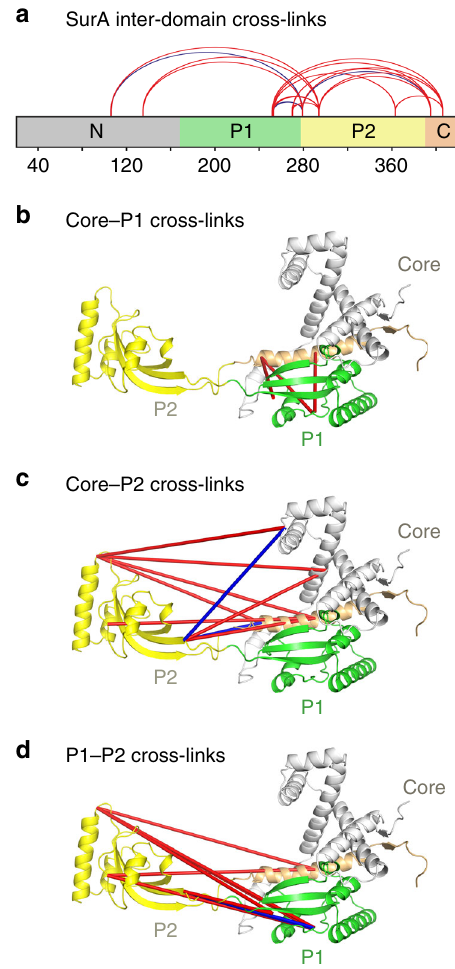
Fig. 2 XL-MS suggests the P2 domain is closer to the core/P1 than implied by the crystal structure. a Locations of the 19 identi fi ed SurA inter- domain cross-links (red and blue lines). b – d Crystal structure of SurA showing the identi fi ed inter-domain cross-links between b core-P1 (3 in total), c core-P2 (9 in total), and d P1-P2 (7 in total). Only four of the inter- domain cross-links identi fi ed (coloured in blue) are consistent with the crystal structure of full-length SurA (PDB 1M5Y 27 ), based on a maximum SASD of 35 Å 35 . Other cross-links are inconsistent with this distance cut- off (red lines). Details of cross-linked residues are given in Supplementary Table 1. A representative mass spectrum for each cross-link can be found in Supplementary Data 1. Reactions contained 5 µ M SurA, 50 µ M DSBU, in 10 mM potassium phosphate buffer, pH 8.0, for 45 min, 25 °C. Note that for clarity cross-links are shown as straight lines between residues (rather than as SASDs which provide a more reliable measurement for comparison with protein structures (see text)). The N-terminal region of the core domain, P1, P2 and the C-terminal region of the core domain are shown in grey, green, yellow and orange, (Supplementary Fig. 4, Supplementary Table 1), but there is some suggestion of local fl uctuations within the domain structures, with fi ve unsatis fi ed cross-links (K90-K134, K134-K394 and K134- K405 in the core domain, and two, K278-K293 and K362-K388, in the P2 domain). Interestingly, two of the fi ve unsatis fi ed intra- domain cross-links (K134-K394 in the core domain, and K362- K388 in the P2 domain) involve a residue that was not present/